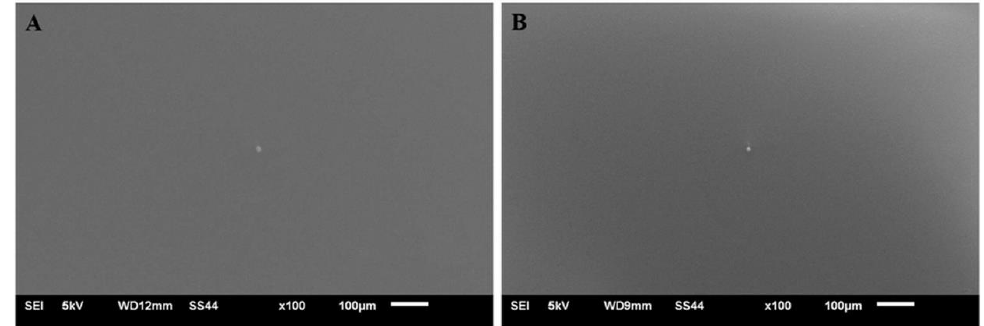
Figure 2. VTMS coating on the Ti Gr 2 ( A ) and Ti13Nb13Zr ( B ) substrates. Photos were taken with a JEOL JSM-6610 LV scanning electron microscope.